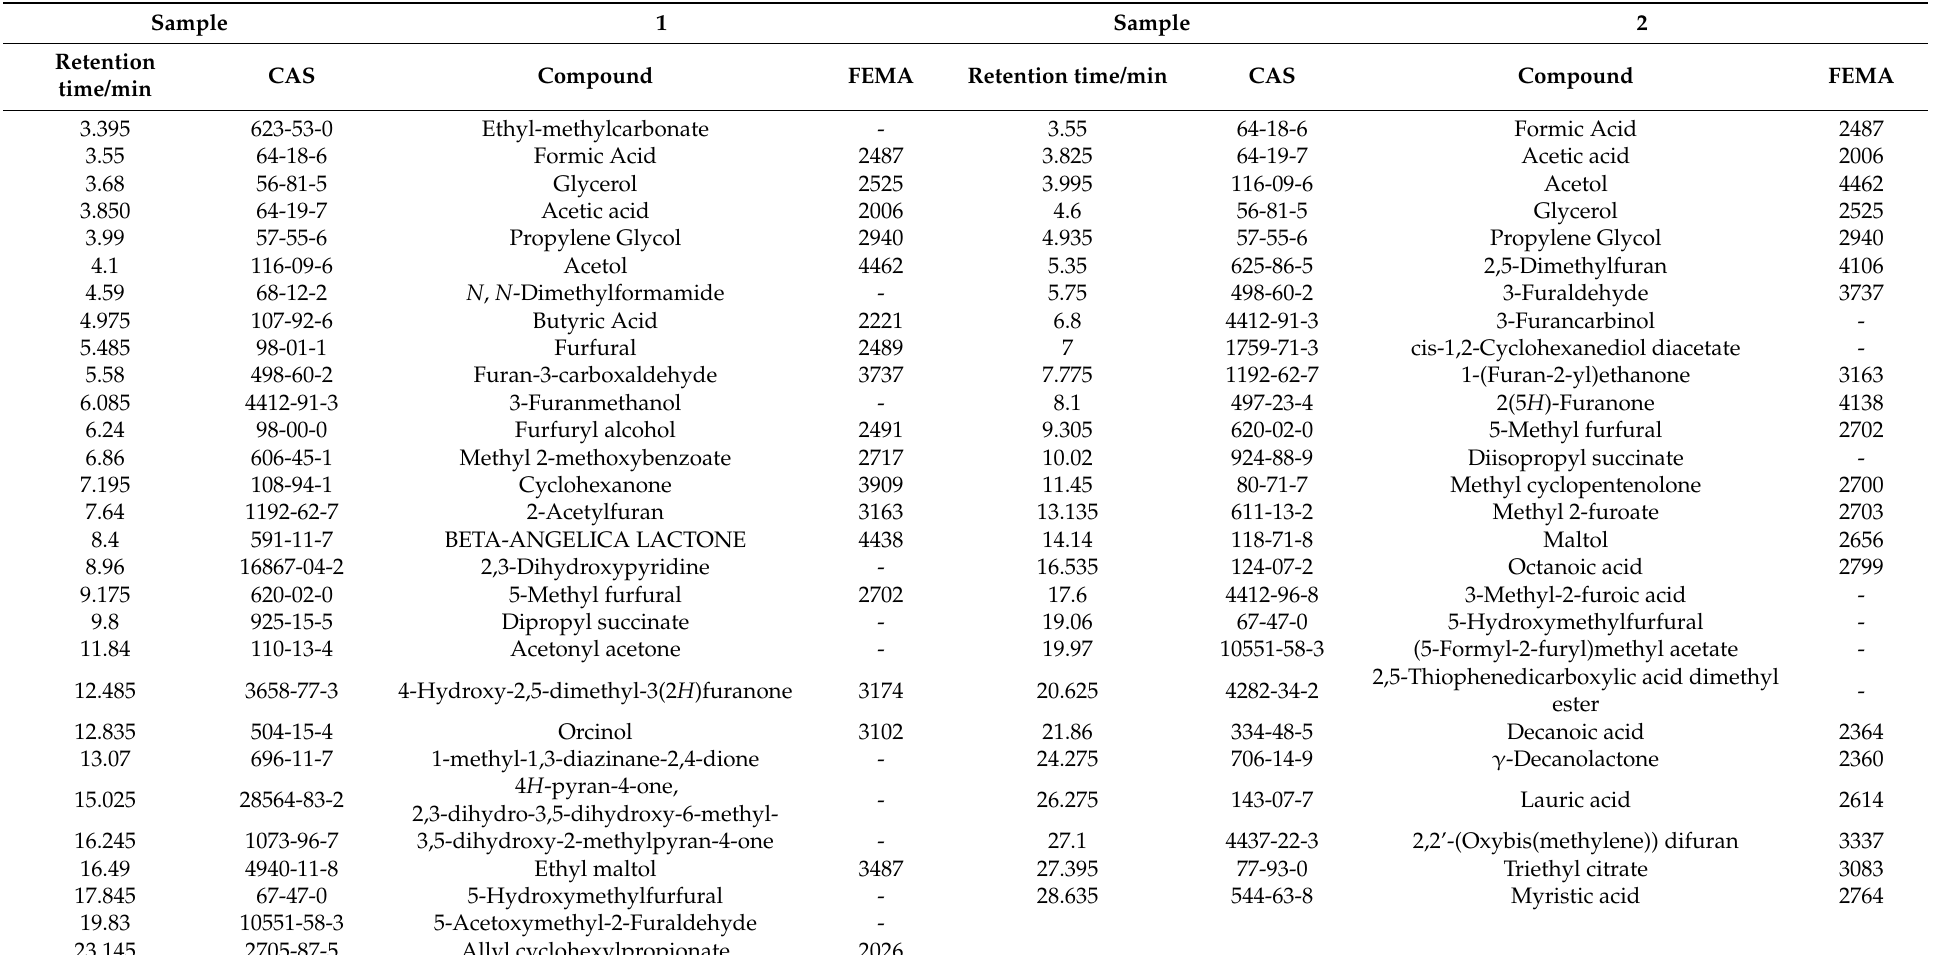
Table 2. Identification results of ice cream samples 1–10 by